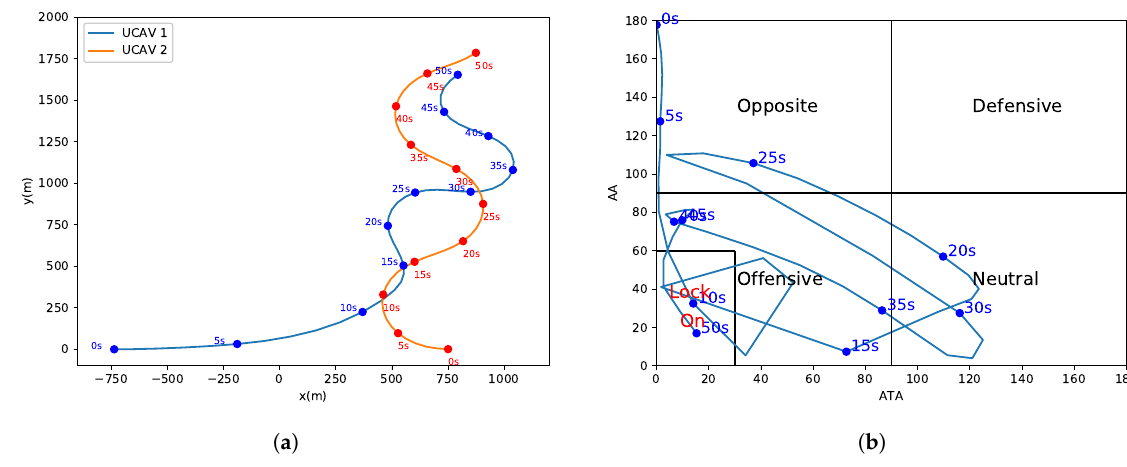
Figure 10. ( a ) Curve of fly trajectory against “S-type maneuver” strategy. ( b ) Curve of the change of air combat situation against “S-type maneuver” strategy. Table 2. Evaluation metrics of the air combat